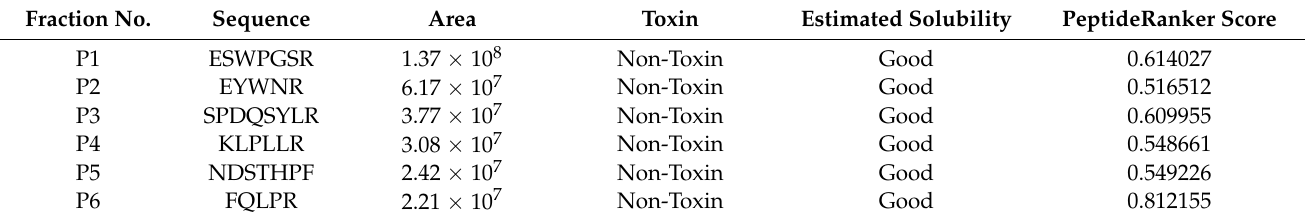
Table 2. Spectral intensity, predicted toxicity, solubility, and bioactivity scores of selected peptides. Fraction